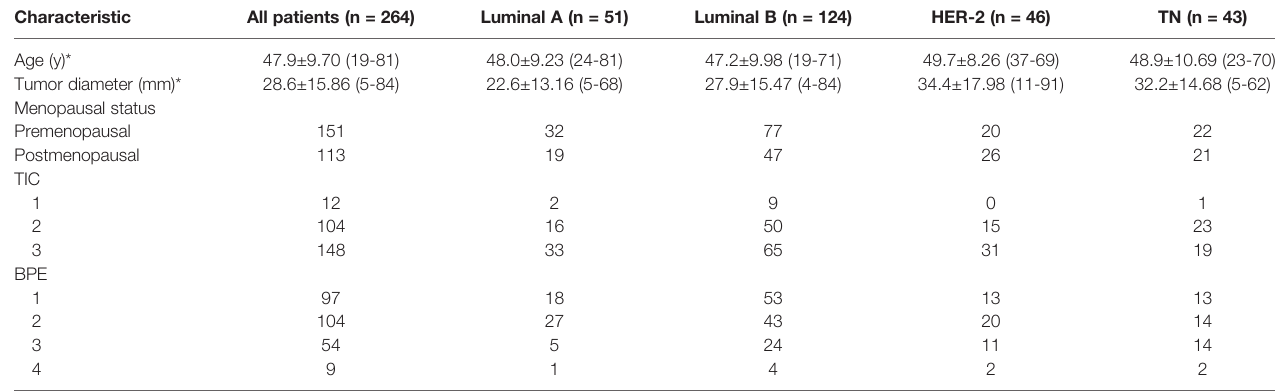
TABLE 1 | Baseline